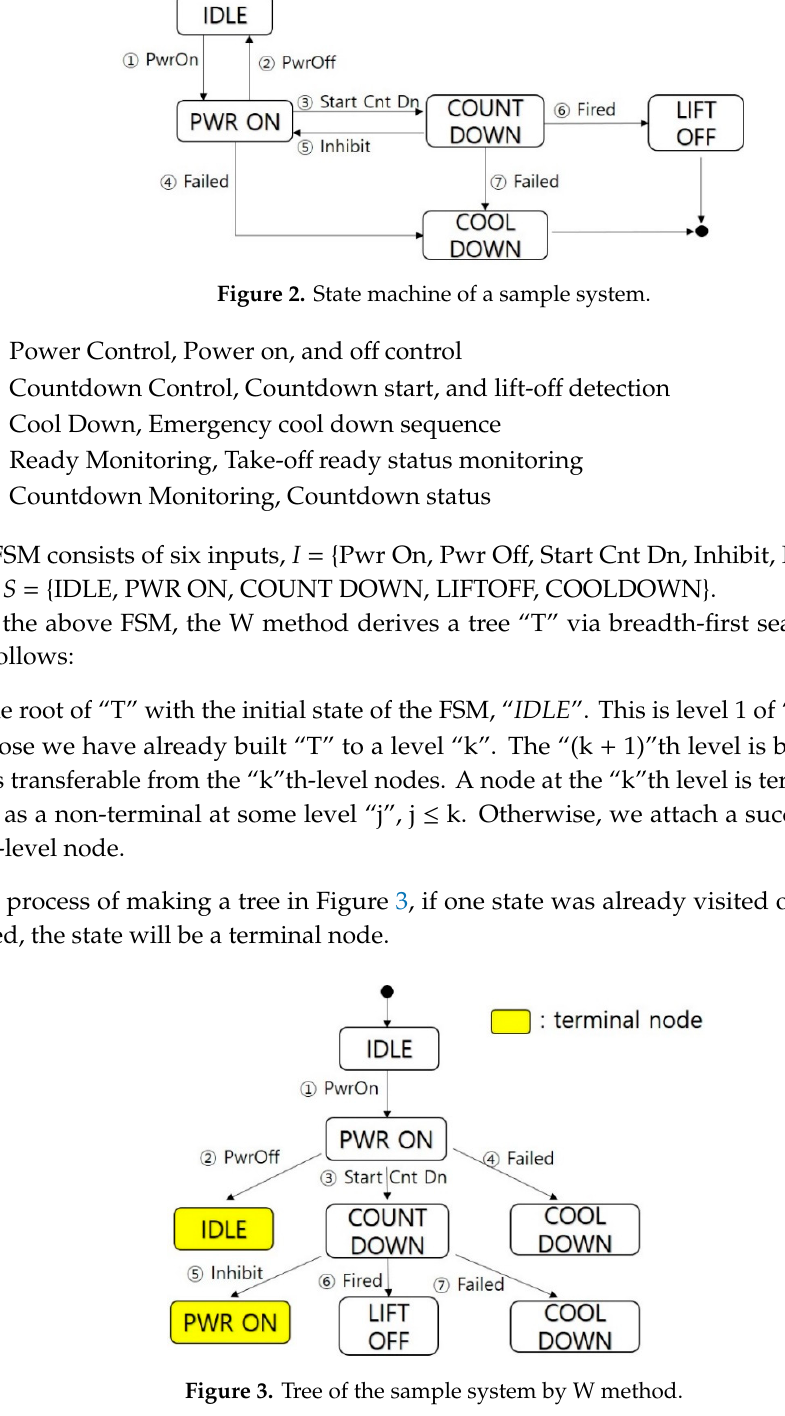
Table 1. Test suite by W method.